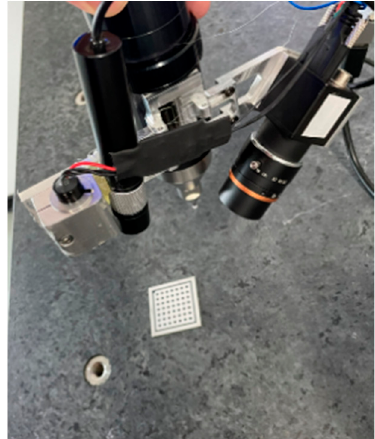
Figure 11. One of the six postures captured.